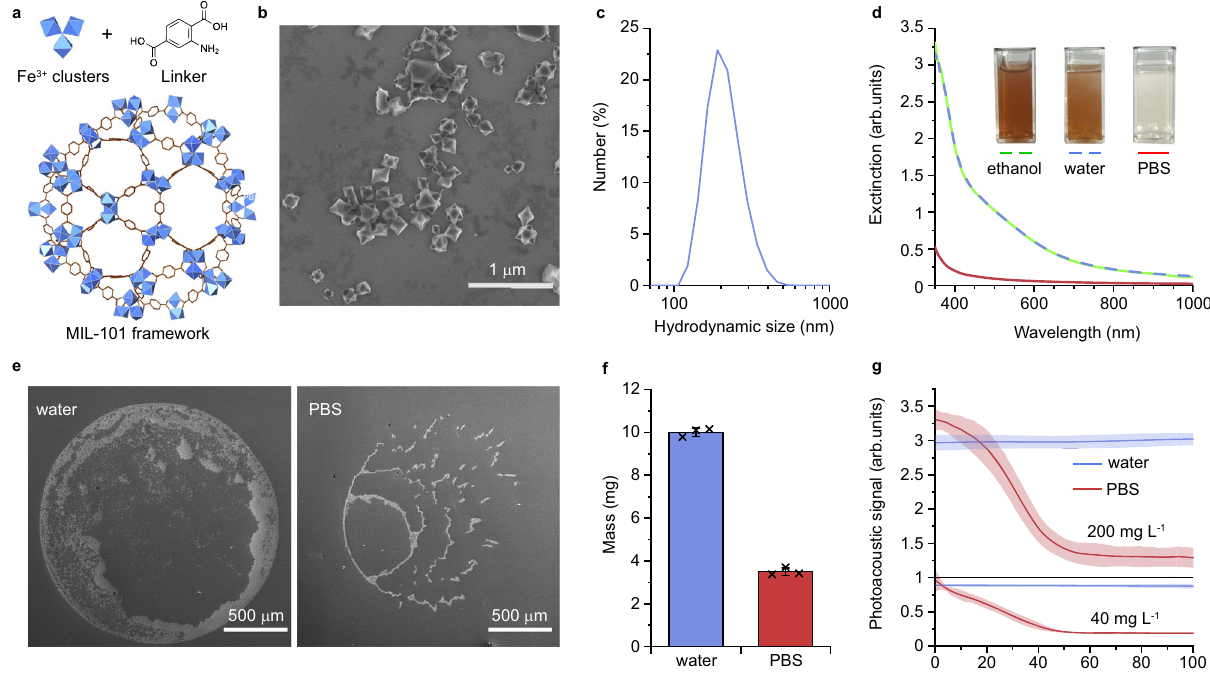
Fig.2|CharacterisationofMIL-101nanoparticlesandtheirdegradationinPBS. a Schematic representation of the pore structure of MIL-101 nanoparticles (NPs). b Scanning electron microscopy (SEM) micrograph of MIL-101 NPs, n =1 sample. Scale bar=1 µ m. c Hydrodynamic size distribution of MIL-101 NPs in water, n =1sample,3repetitions. d ExtinctionspectraofMIL-101NPs24-hpostincubation inethanol(green),water(blue),andPBSbuffer(red).Inset — imagesofcuvetteswith NP solutions in dispersants, n =1 measurement. e SEM images of two droplets of